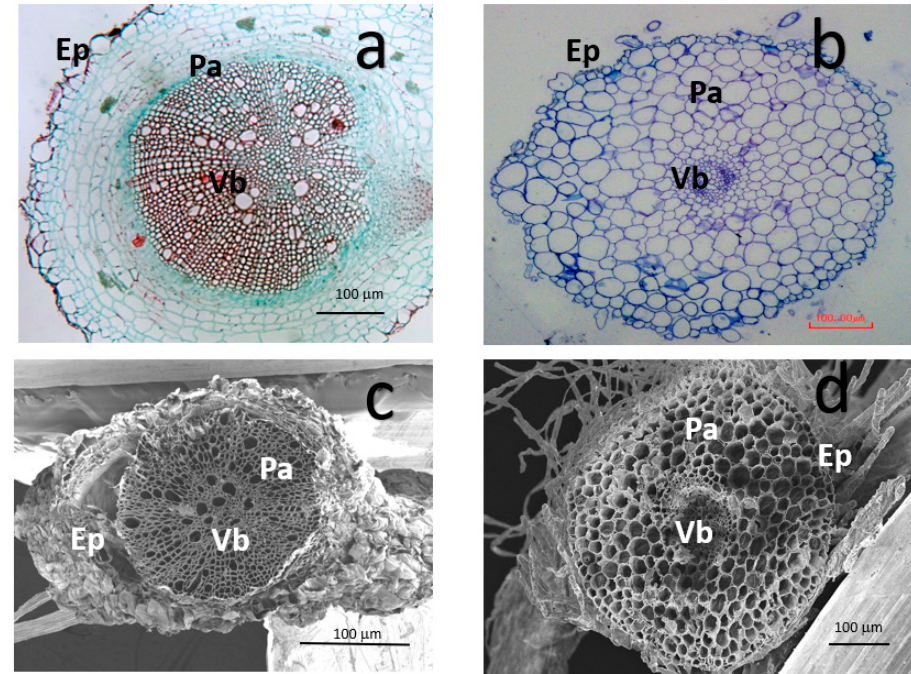
Figure 6. Microstructure characterization of tomato root at 21 days of growth in LM and SEM. Tomato root control ( a , c ) and exposed to TiO 2 NPs ( b , d ) with LM and SEM, respectively. The results show that tomato roots exposed to TiO 2 NPs had a decreased area from 260.92 ± 41.15 µ m 2 to 160.71 ± 22.93 µ m 2 ( p < 0.05) in Ep and Vb, area changes from 103.08 ± 13.88 µ m 2 to 52.13 ± 7.16 µ m 2 . Similarly, the Pa tissue is observed to increase area from 337.72 ± 24.23 to 892.96 ± 463.3 µ m 2 ( p < 0.05) ( p < 0.05, Figure 7).